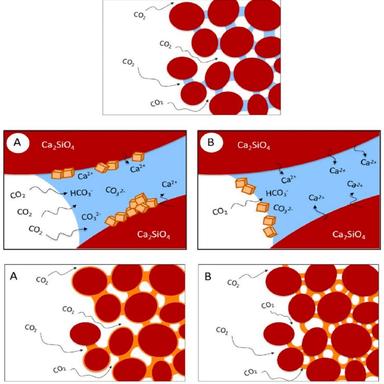
Schematic diagram of calcium carbonate crystal precipitation at (A) low temperature (10–20 ◦C) and (B) high temperature (60 ◦C).